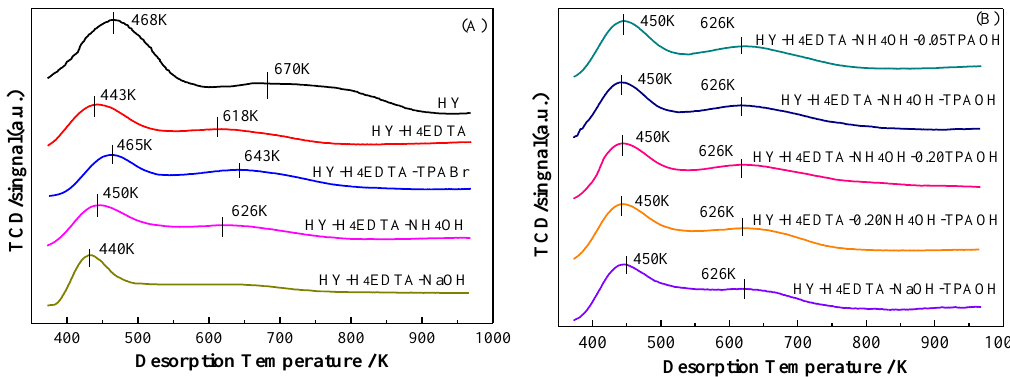
Figure 2. NH 3 -TPD analysis of the parent HY and the optimized hierarchical HY zeolites ( A ) and ( B ).